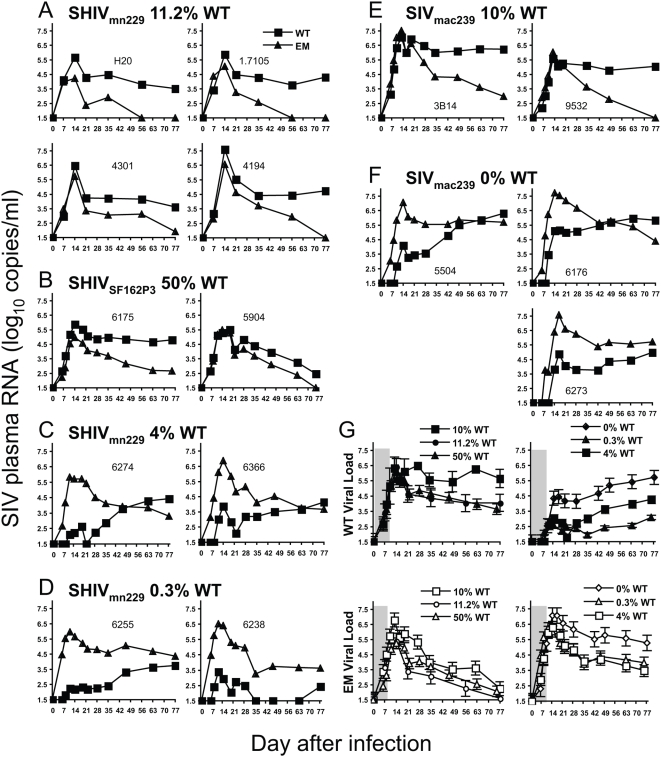
Reversion to WT for different viruses and percentages of WT in the inocula.(A–F) Shows WT (squares) and EM (triangles) plasma viral loads over time by qRT-PCR from individual pigtail macaques inoculated with different viruses over 11 weeks. (A) SHIVmn229 stock with 11.2% WT virus at KP9 CD8 T cell epitope (four animals) (B) In vivo passage of SHIVSF162P3 with 50% WT virus at AF9 CD8 T cell epitope (2 animals). (C) In vivo passage of SHIVmn229 with 4.0% WT virus at KP9 (2 animals). (D) In vivo passage of SHIVmn229 with 0.34% WT virus at KP9 (two animals). (E) Mix of SIVmac239 molecular clones containing 10% WT virus and 90% K165R EM virus. (F) Pure SIVmac239 molecular clone of 100% K165R EM virus (0% WT, 3 animals). (G) Mean (±SEM) of WT (upper panels) or EM (lower panels) viral loads of groups of animals given the same virus. Animals administered mixes of EM and WT virus with ≥10% WT have similar WT and EM viral loads and are grouped together (left panels) in comparison to animals administered viruses with <10% WT content (right panels). The first 10 days are shaded to indicate the differences in WT virus expansion between the two types of viruses.